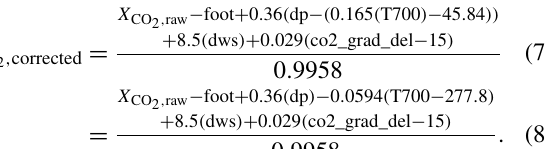
≡ (OCO-2 retrieval) i − ( ˜ X NNG ) i ) for each 2